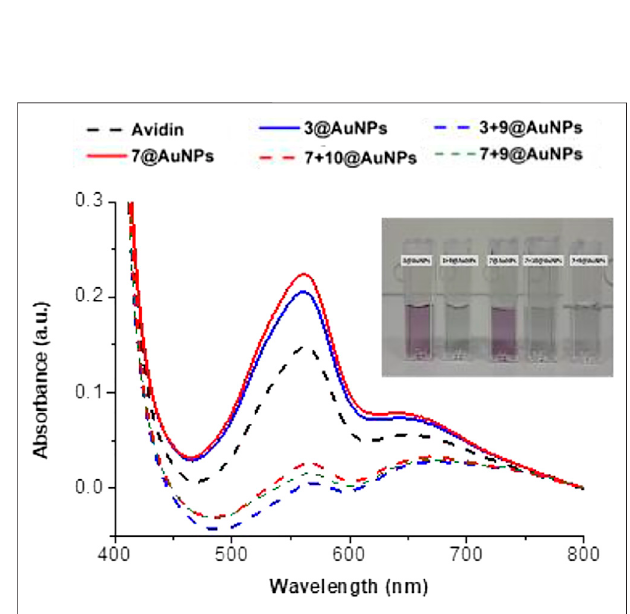
FIGURE 8 | Evaluation of avidin interaction with non-biotinylated and biotinylated AuNPs analyzing washing supernatant by BCA assay. appeared stable but, probably, a partial unspeci fi c binding of proteins occurred.